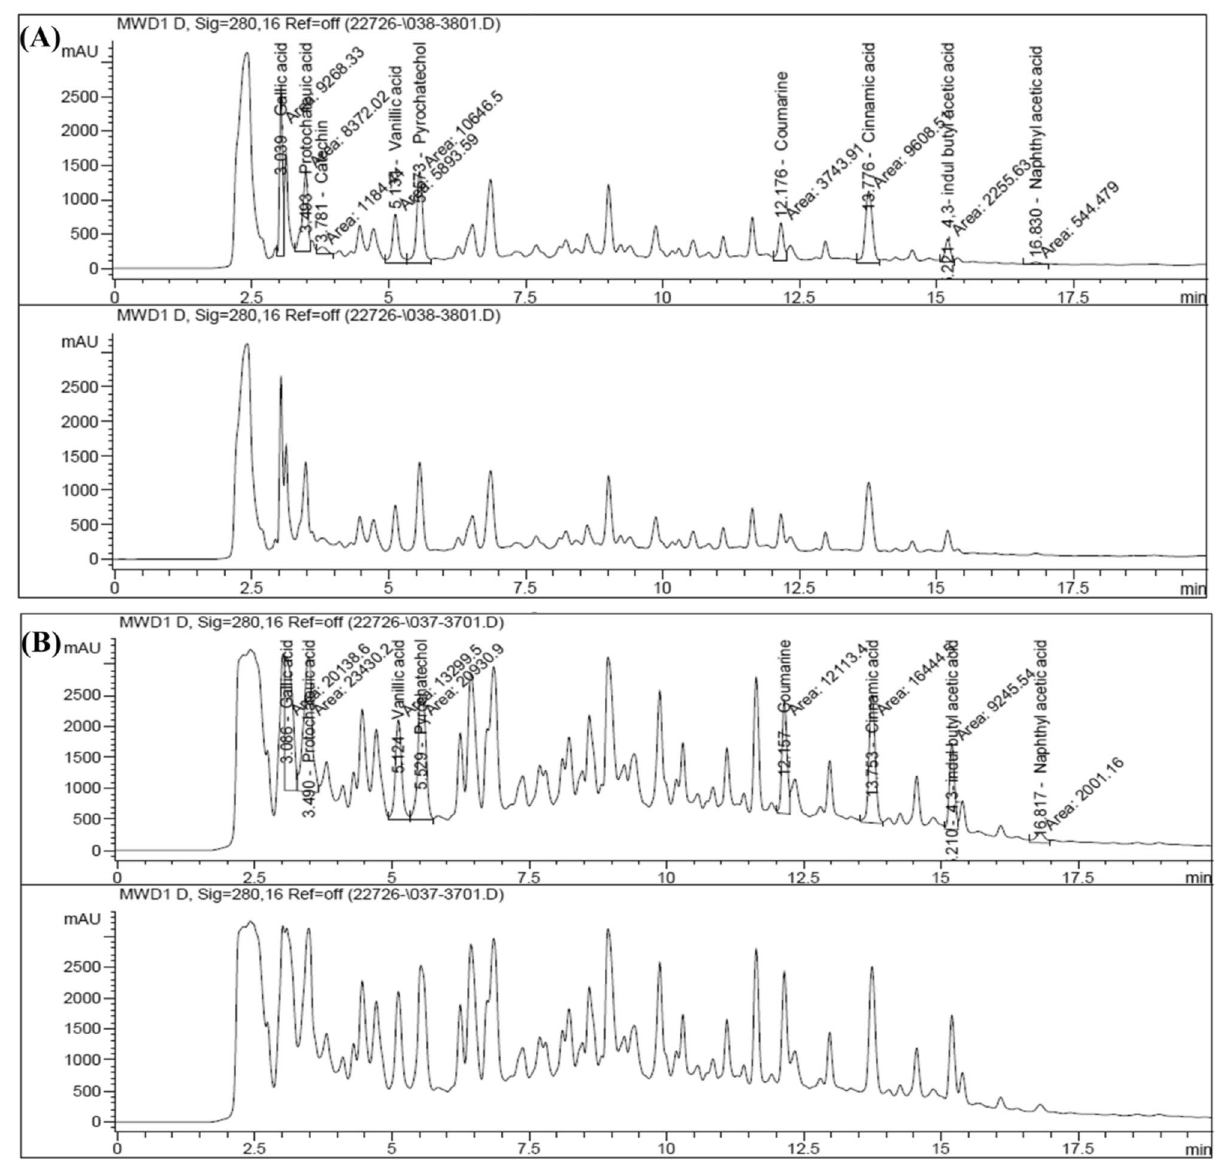
Figure 8. HPLC analysis of polyphenolic compounds ( A ) HPLC analysis of bioactive compounds in the Salix mucronata 50% EE and ( B ) HPLC analysis of bioactive compounds in the Salix mucronata 100%